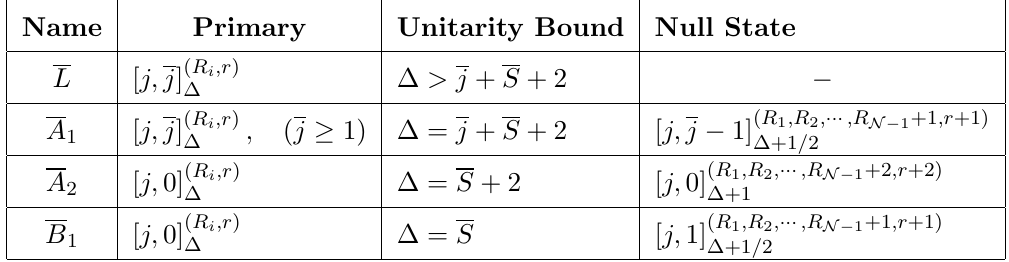
Table 31 . The antichiral half of unitary representations of the 4 d superconformal algebras. (In the special case N = 4 ; the charge r is absent.)